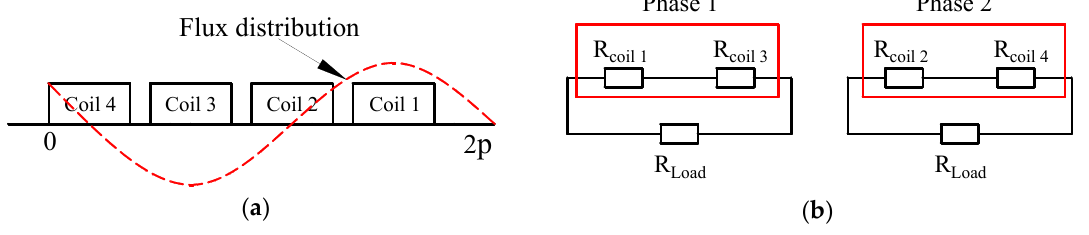
Figure 2. ( a ) Coils and excited flux density; ( b ) External circuit.